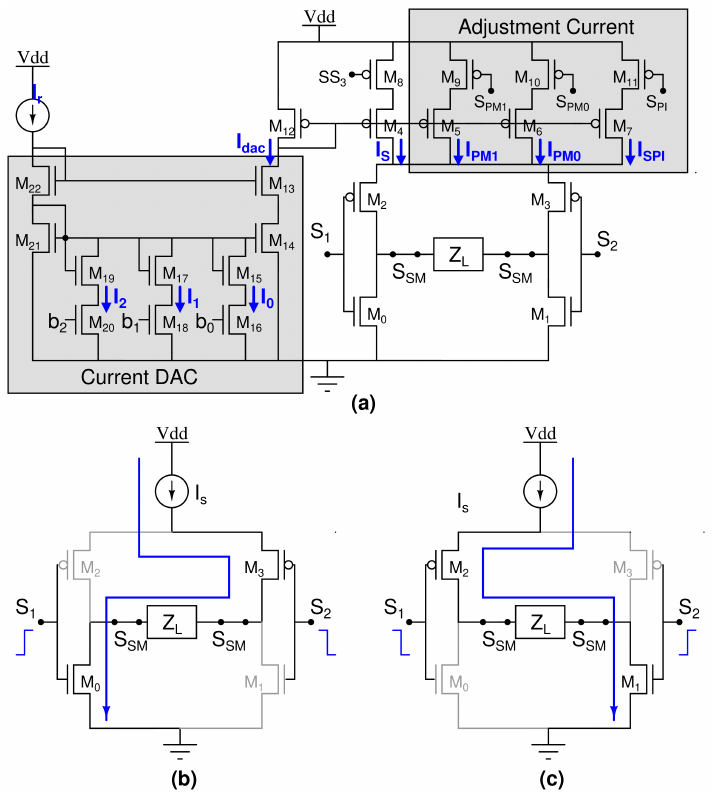
Figure 4. ( a ) Stimulation circuit. ( b ) Cathodic configuration. ( c ) Anodic